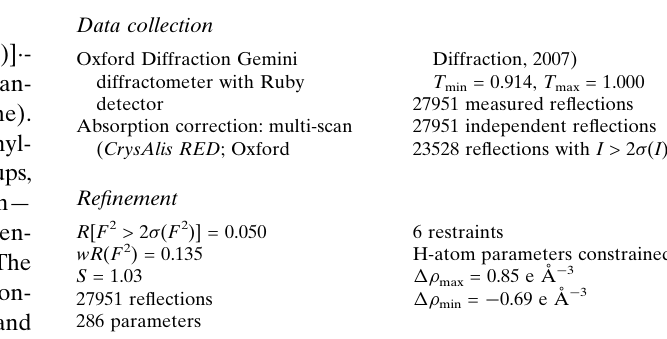
Diffraction, 2007) T min = 0.914, T max = 1.000